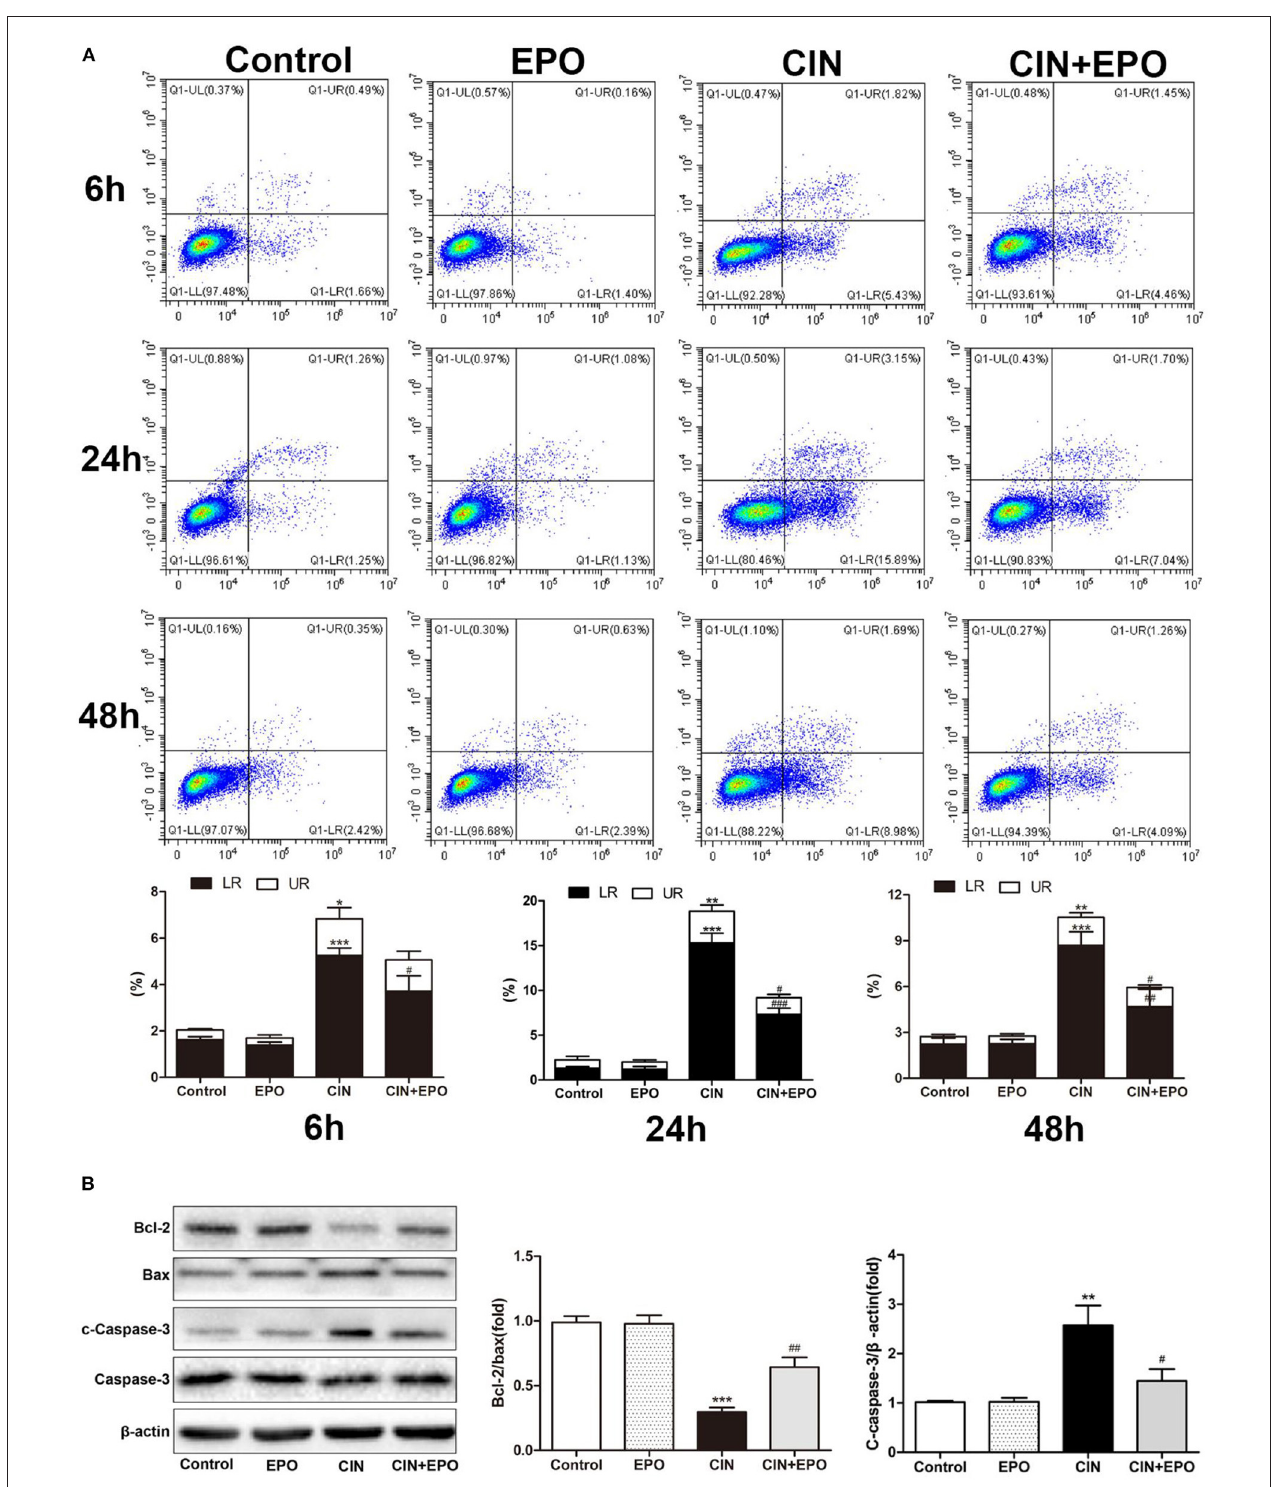
FIGURE 5 | Effect of EPO on apoptosis induced by contrast in HK-2 cells. (A) Annexin V/PI assay was used to assess the cell apoptosis and pyroptosis in the presence and absence of EPO. (B) Apoptosis-related proteins, including Bax, cleaved caspase-3, and Bcl-2, were determined by Western blot assay. Each bar represents the mean ± SD calculated from three independent experiments. * P < 0.05, ** P < 0.01, *** P < 0.001 vs. the control group; # P < 0.05, ## P < 0.01, ### P < 0.001 vs. the CIN group. EPO, erythropoietin; CIN, contrast-induced nephrology; PI, propidium iodide.